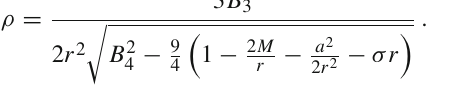
Fig. 3 The density function ρ versus r for KS, RN, and SCH black holes in which we have set M = 1, A 3 = ˜ A 3 = K 3 = 1, A 4 = ˜ A 4 = K 4 = 1, Q = 0 . 4, and a = 0 . 8. The red dot-dashed line, the blue dashed line, and the thick black line are for the KS, RN, and SCH cases, respectively. Also, the green dashed line shows the surface of the central 2-sphere in this two dimensional figure at which the curve of the proper energy density in the KS black hole is bounded. The choice of a = 0 .